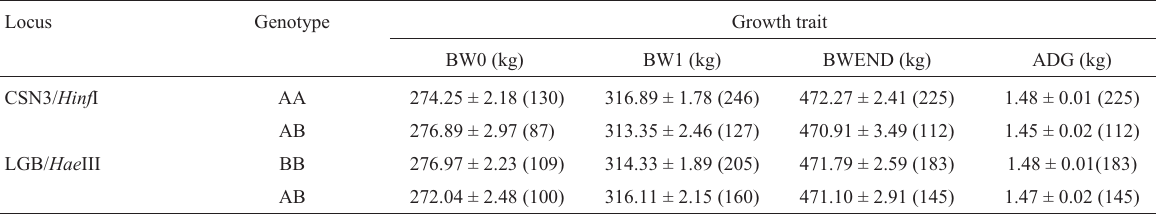
BW0 = body weight at the time of entry in the pen; BW1 = body weight at the beginning of feedlot; BWEND = body weight at the time of slaughter; ADG = average daily gain. No significant differences were observed between genotypes (p > 0.05). Table 4 - Least square means and standard errors of the carcass traits for the genotypes of the CSN3/ Hinf I and LGB/ Hae III loci. The number of animals compared in each genotype is given in parentheses. Locus